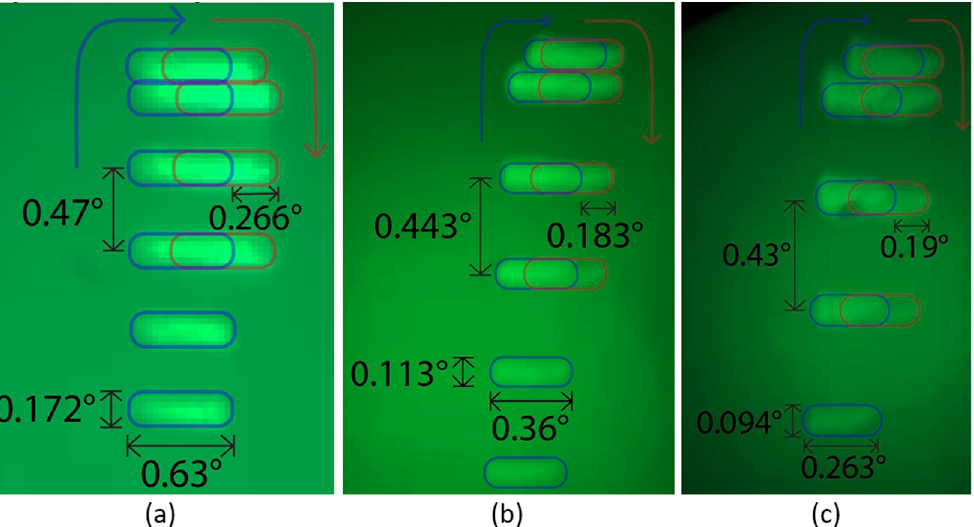
Figure 8. Angular spot separation and spot extent for horizontal and vertical directions for ( a ) 1 m, ( b ) 2 m, and ( c ) 3 m distances. The pictures show the top portion of the sub-FOV depicted in Figure 8b. Table 1. Angular spot size and angular spot separation for horizontal and vertical directions.